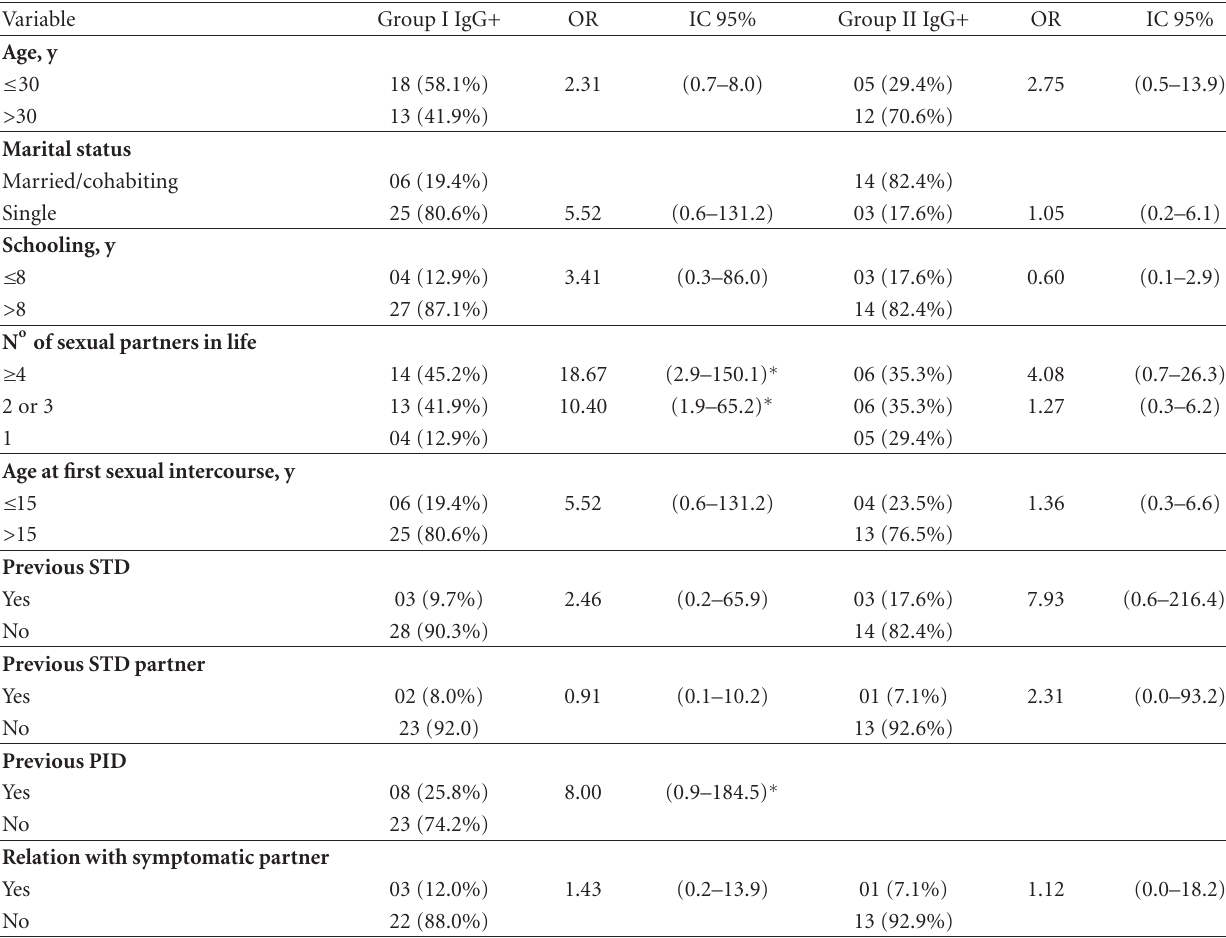
Table 2: Univariate analysis of the characteristics associated with the presence of chlamydia IgG antibodies in women with tubal occlusion or previous ectopic pregnancy (group I, n = 55) and in parous women (group II, n = 55), in Goiˆania, Goi´as, Brazil, in